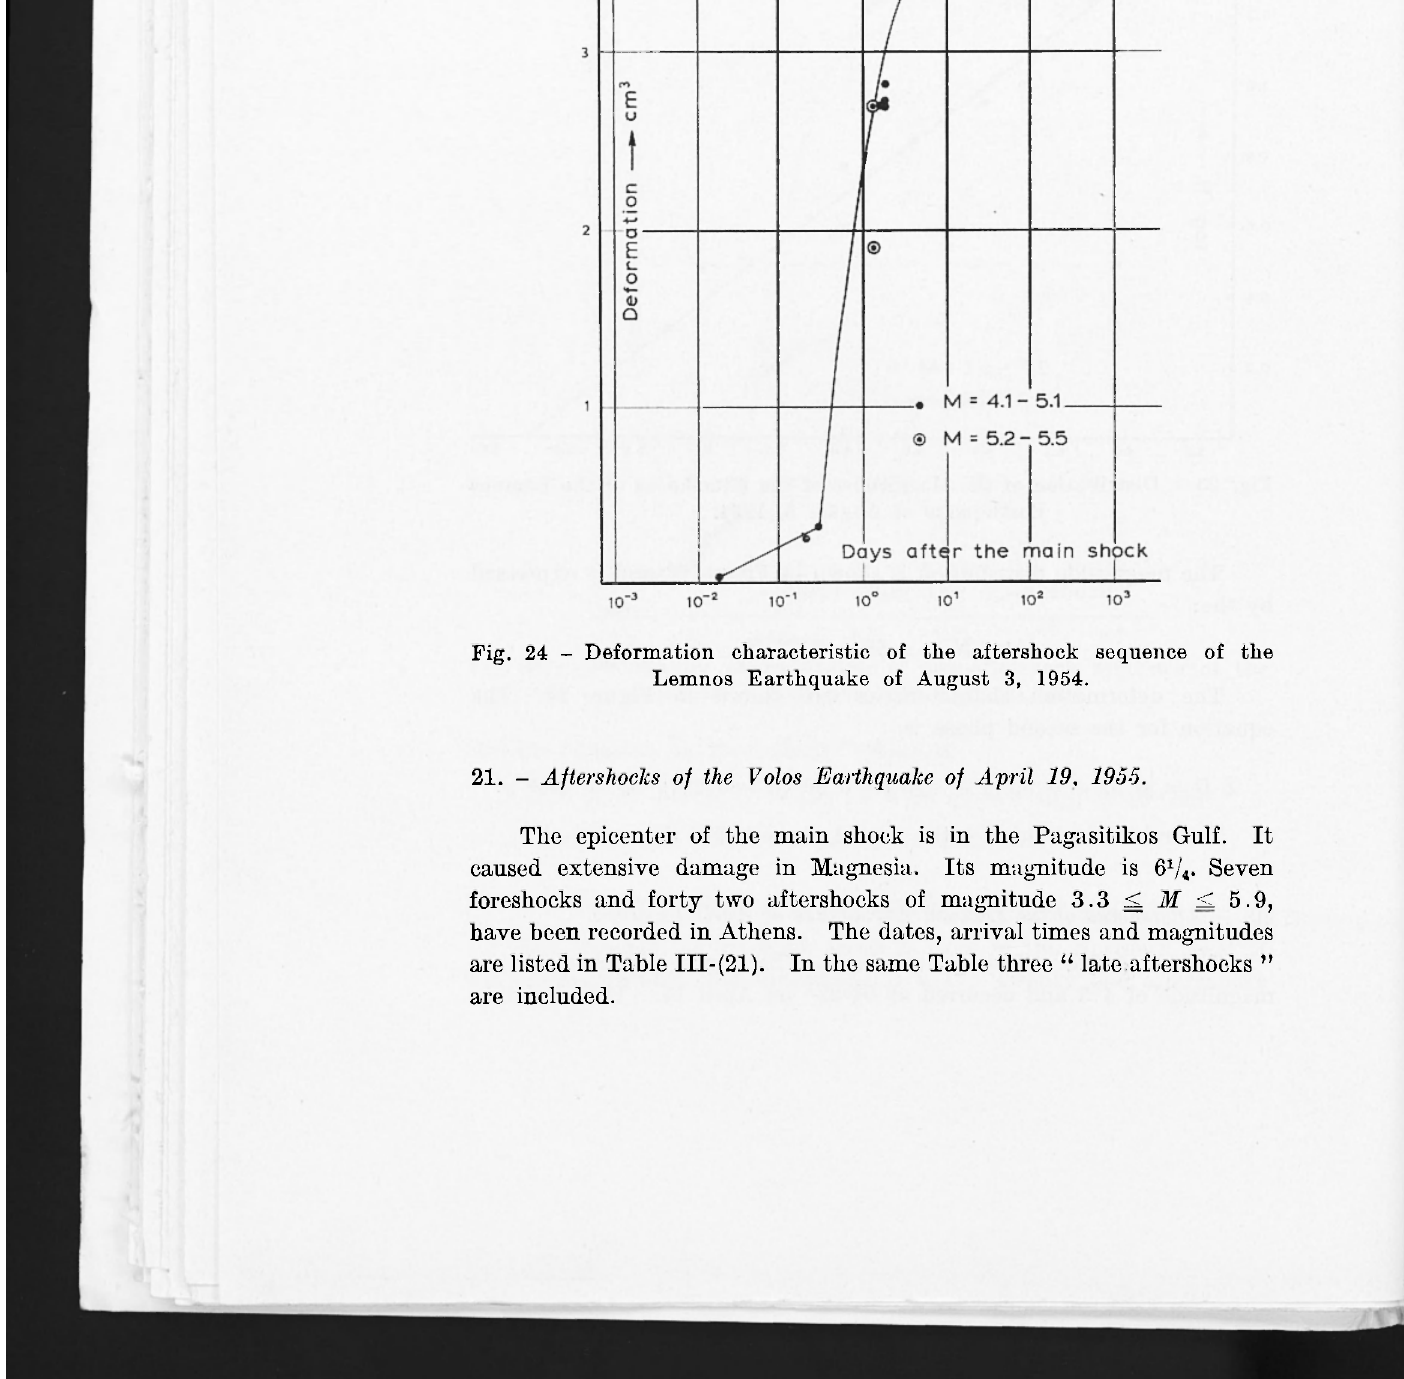
Fig. 24 - Deformation characteristic of the aftershock sequence of the Lemnos Earthquake of August 3, 1954.